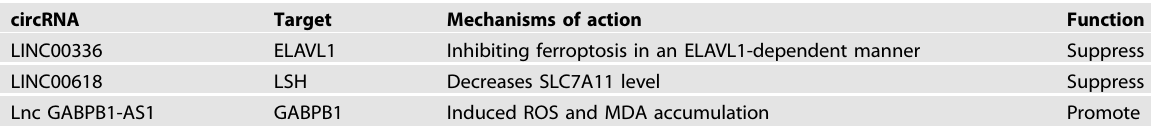
Table 2. lncRNA associated with ferroptosis.